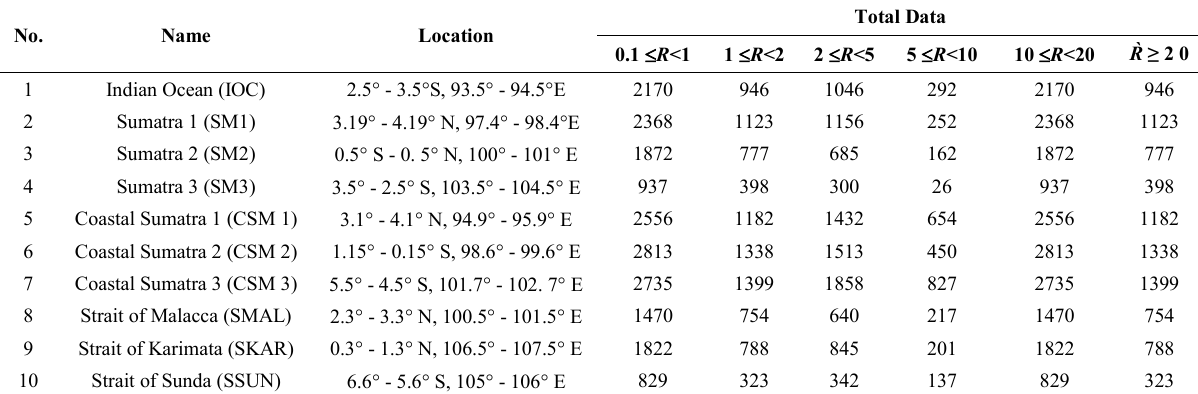
Table 1. Distribution of data for several locations of stratiform rain from GPM